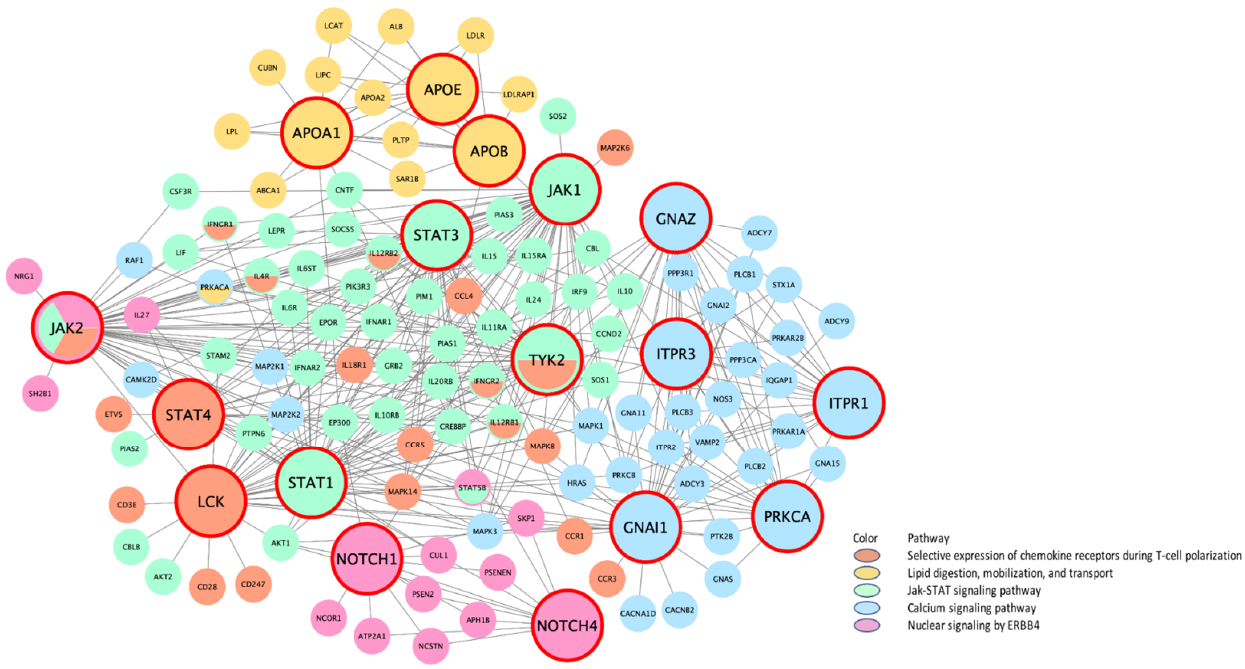
Figure 6. PPI-specific gene-regulatory networks of top KDs in meta-analysis of CRP and IL6 on eQTL-based mapping. (CRP, C-reactive protein; eQTL, expression quantitative trait loci; FDR, false discovery rate; IL6, interleukin-6; KD, key drivers; PPI, protein-to-protein interaction. The bigger nodes with red outlines are the top KDs in the enriched pathway obtained from weighted KD analysis. The subnetworks of the KDs are indicated by different colors according to differences in their canonical functions.).